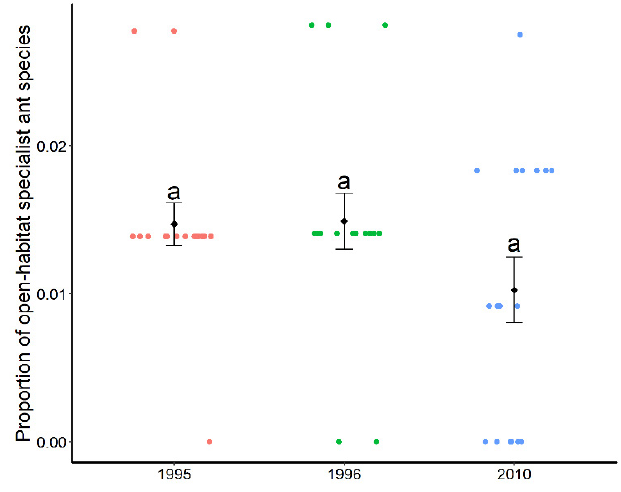
Fig 6. Average proportion of open-habitat specialist ant species richness across studied fragments, located in southeastern Brazilian Atlantic rain forest. Open-habitat specialist species was similar among years in fragments located in southeastern Brazilian Atlantic rainforest (p = 0.41). Points represent the proportion of open-habitat specialist ant from each fragment sampled in each year. The black lozenges represent the average and the bars represent the standard error. Different letters represent significant differences at alfa = 0.05.